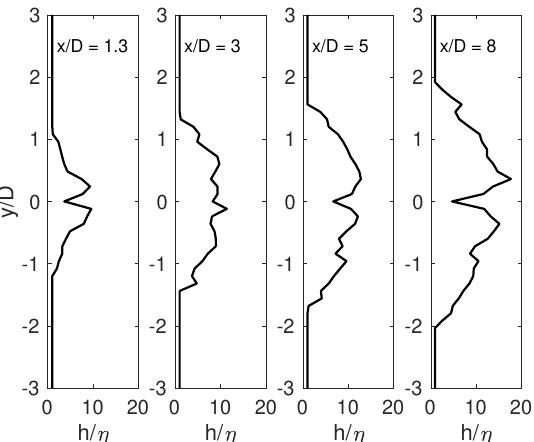
Figure A1. Ratio of the grid size to the Kolmogorov length scale ( h / η ) at different locations in the near